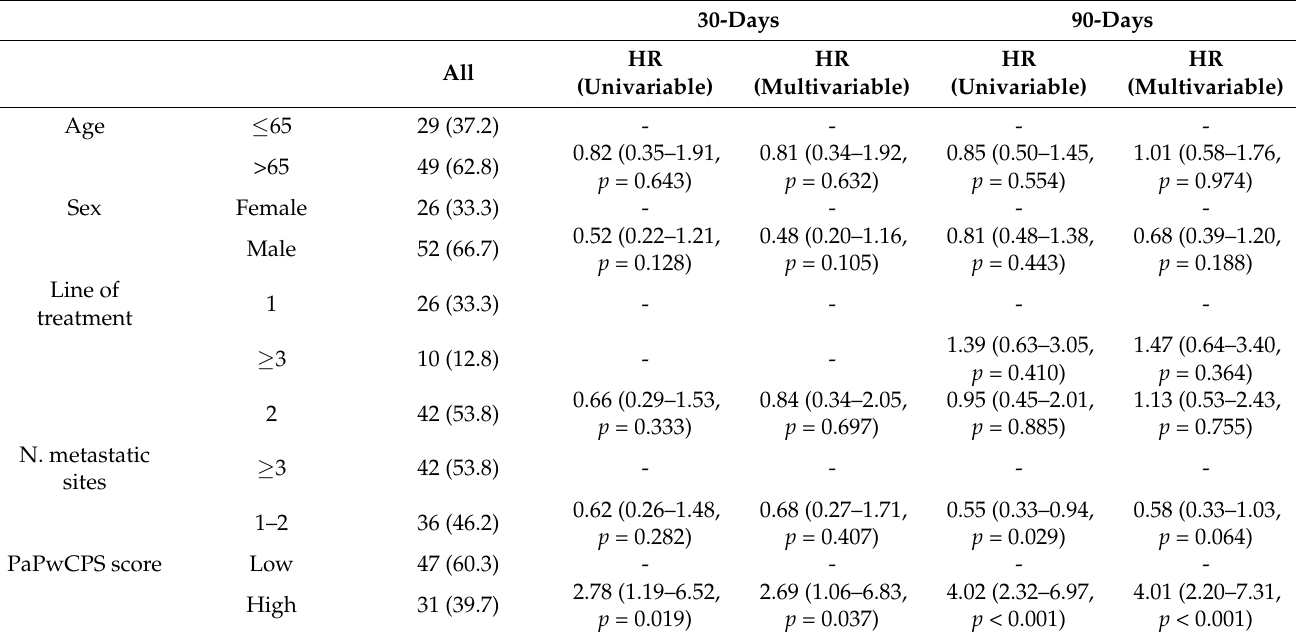
Table 3. Univariate and multivariate analyses for 30-day and 90-day survival, including PaPwCPS score. Abbreviations: HR, hazard ratio; n., number.